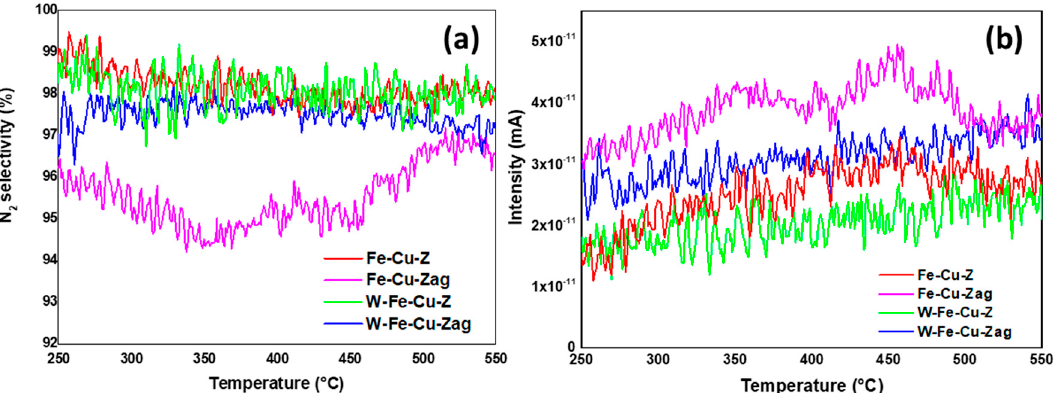
Figure 11. ( a ) N 2 selectivity and ( b ) Evolution of N 2 O + fragment (m/e = 44) intensity over studied catalysts.